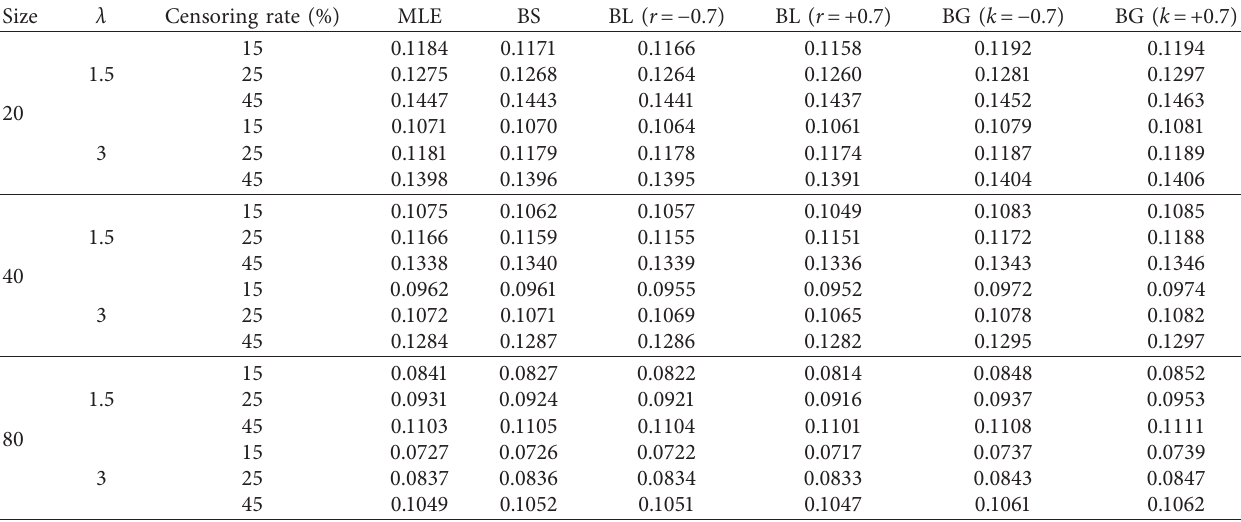
Table 2: MSE estimations of λ with a cure fraction based on interval-censored